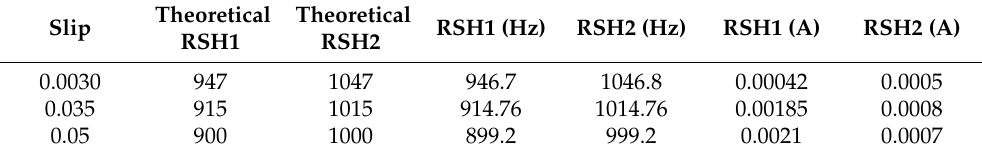
Table 3. The rotor slot harmonics